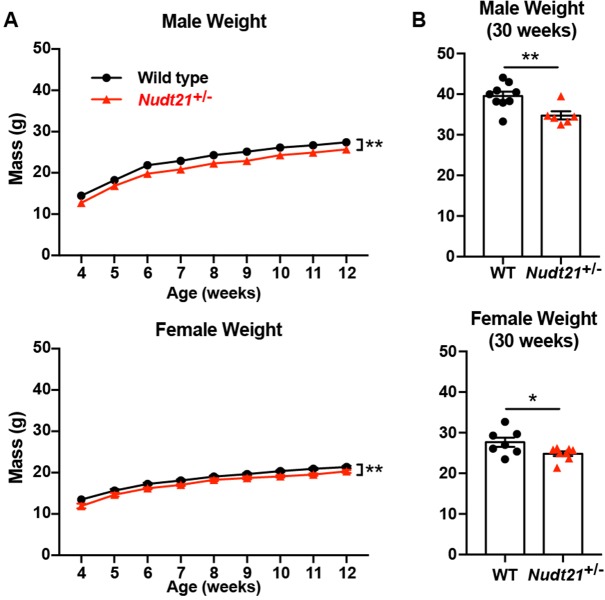
Nudt21+/-mice weigh less.(A) Male (top) and female (bottom) Nudt21+/- mice weigh less than their wild-type littermates from weening to twelve weeks: p=0.002 (males) and p=0.004 (females), analyzed by two-way repeated measures ANOVA (genotype*week). n = 15–26/genotype. (B) Reduced weight persists up to at least 30 weeks in male (top) and female (bottom) Nudt21+/- mice: p=0.008 (males) and p=0.04 (females), analyzed by unpaired, two-tailed t-test. n = 6–9/genotype. Error bars indicate SEM. *p<0.05; **p<0.01.